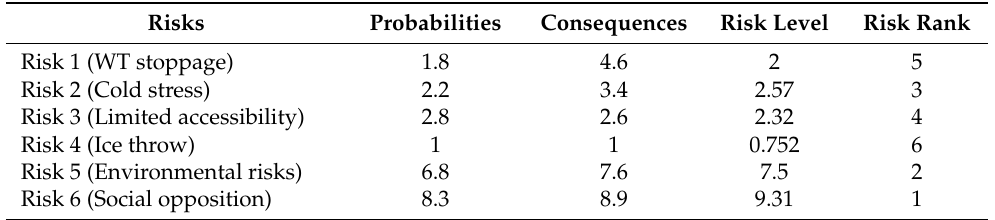
Table 8. Ranking of risks for the Kozbeyli WF in Turkey using experts’ judgments and fuzzy